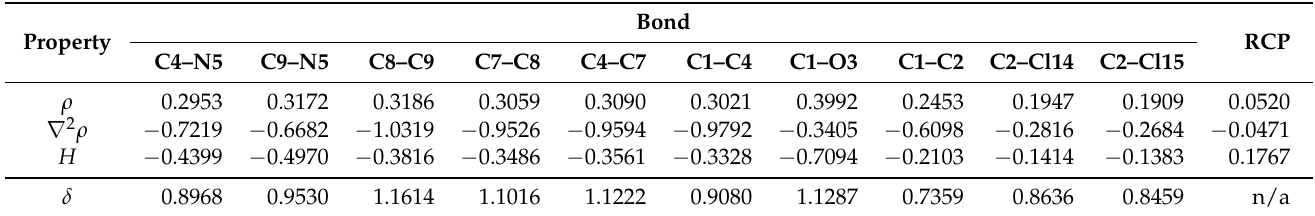
Table 1. Reference values (in a.u.) of the QTAIM-based parameters obtained at the CCSD/aug-cc- pVTZ level of